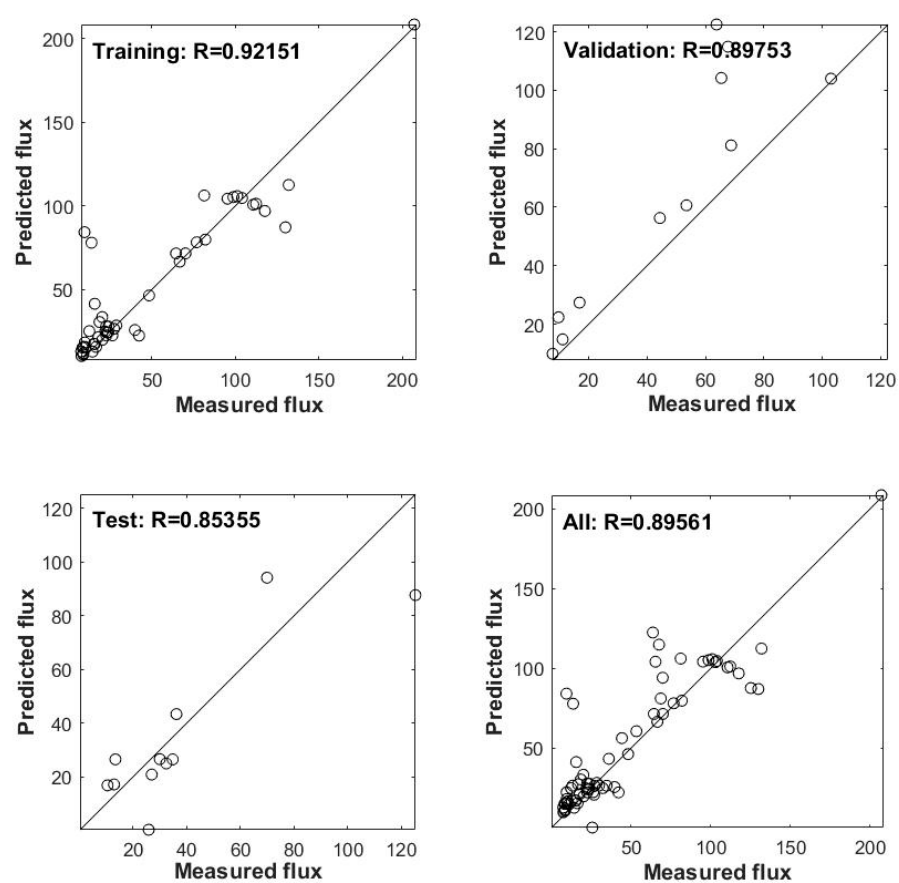
Figure 3. Network training and regression plots for the prediction of methane emissions.